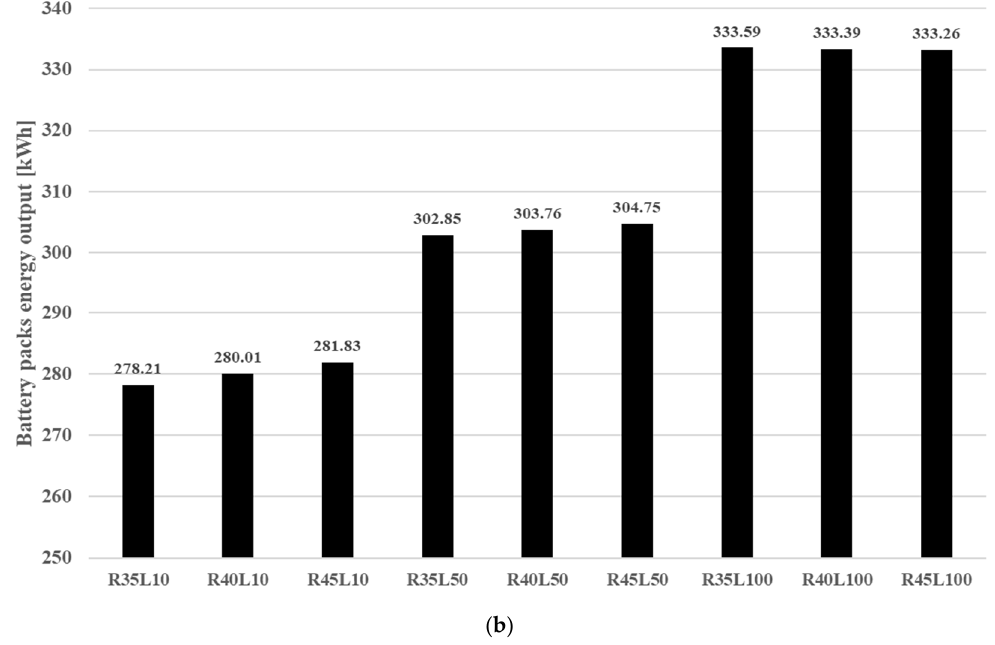
Figure 14. ( a )The regenerative brake energy recovery and ( b ) battery pack energy output during travel for different